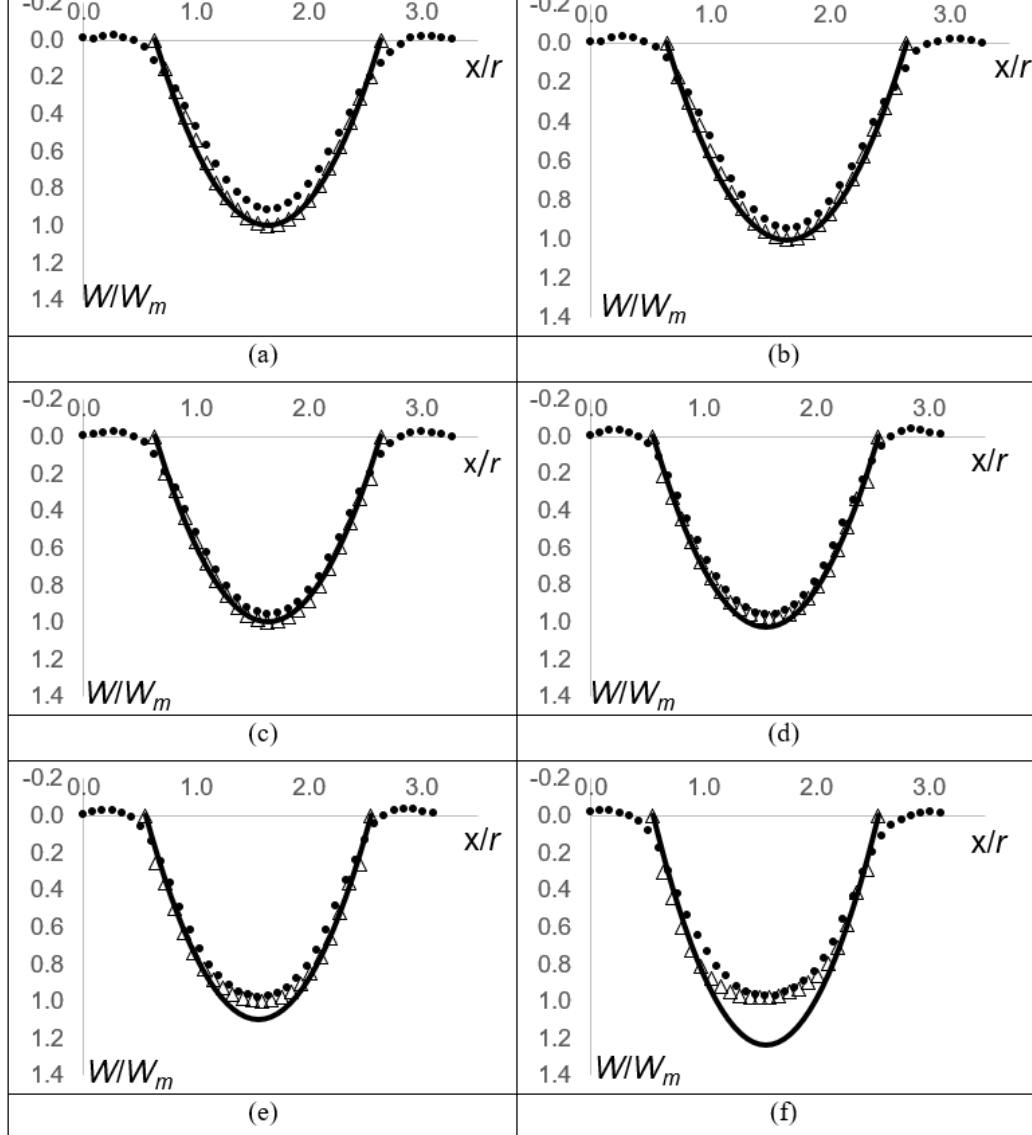
Figure 4. Normalized velocity profiles in correspondence of the maximum vessel diameter for various selected Re : ( a ) Re = 410, ( b ) Re = 600, ( c ) Re = 1100, ( d ) Re = 1600, ( e ) Re = 2000, and ( f ) Re = 2650. Data are from the first set of experiments (ID 1 to 6, Table 1). The profiles refer to the healthy aorta (triangles), the aneurysmatic dilatation (circles) and the analytical Poiseuille profile (black continuous line); the x axis is normalized by the radius of the healthy aorta, r . Flow direction is from up to down.